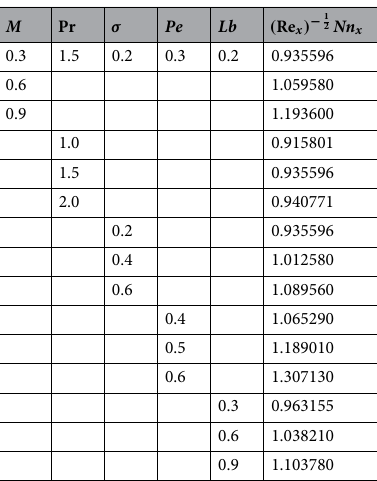
Table 5. Computations of ( Re x ) −